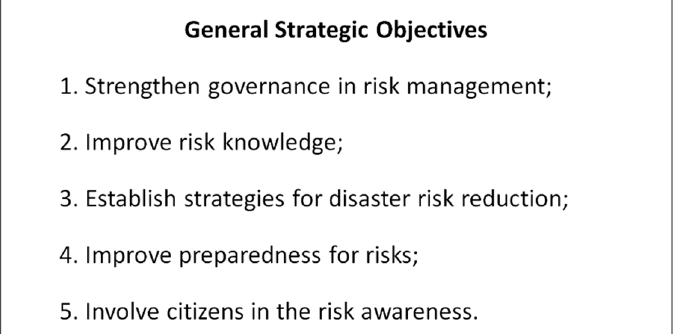
Figure 3. The five general strategic objectives recommended [17].